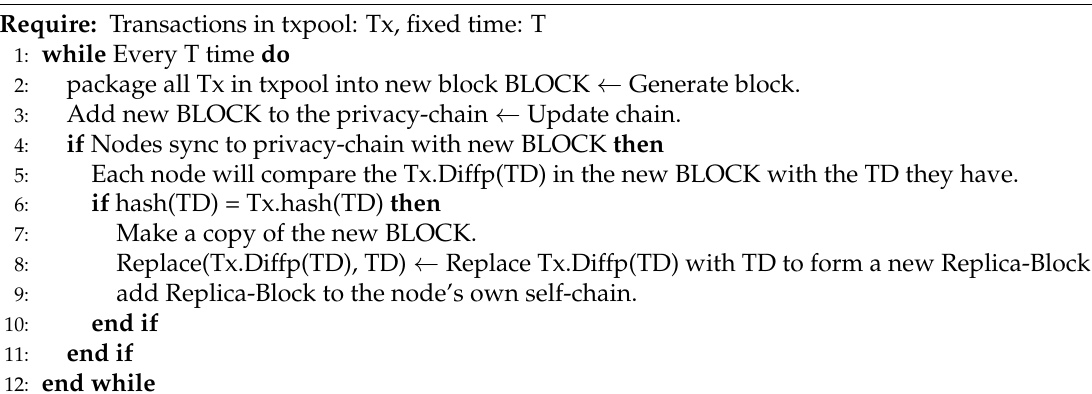
Algorithm 3 Algorithm for primary and secondary chain